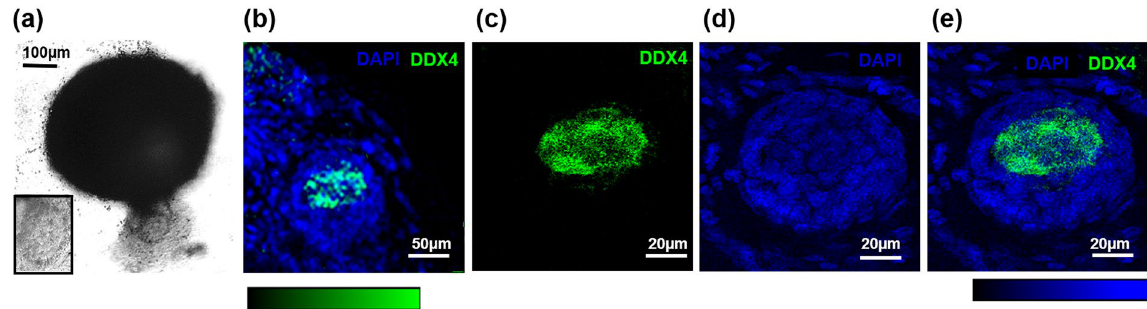
Figure 6. ( a ) DDX4-positive structure was emitted from an aggregate comprised of DDX4-positive sorted cells and FODSCs after 10 days in vitro . Bright field microscopy (x20 magnification, scale bar 100 µ m) identified a structure emitted from an aggregate ( a ). Confocal images of the emitted structure fluorescently immunostained for DDX4 (green) and DAPI (blue) ( b – e ). A DDX4-positive structure is observed within surrounding DDX4-negative cells at X20 magnification, scale bar 50 µ m ( b ). The DDX4 structure at X63 magnification measures 40 µ m ( c ). DAPI staining confirms a multi-laminar structure measuring 60 µ m at X63 magnification ( d ). A merged image shows a multi laminar follicle like structure containing a DDX4-positive central structure, X63 magnification, scale bar 20 µ m ( e